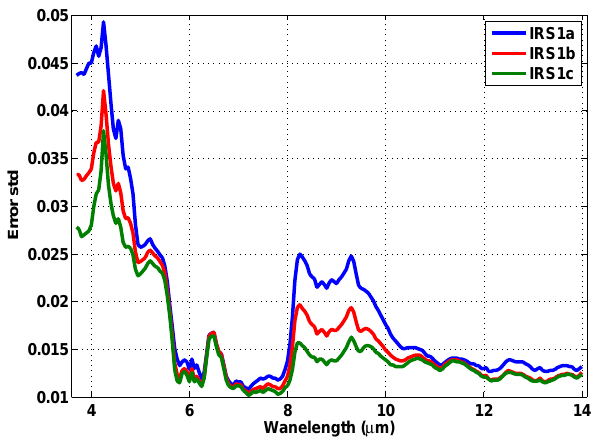
Figure 11. Impact of spectral resolution on the CO lines in the 2135–2185cm − 1 spectral range used for the CO retrieval – aver- age over the whole tropical TIGR